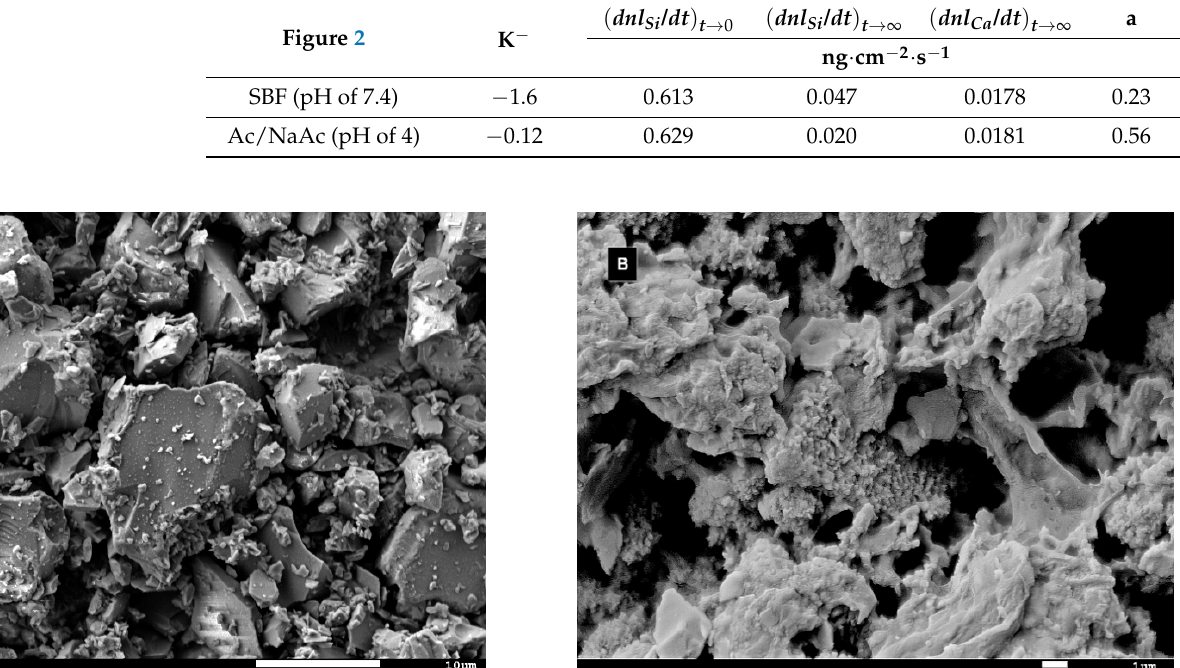
Figure 10. SEM micrographs ( A ) of the VB glass powder after the 4-day flow-through test ( B ) and the inline ICP test in Ac/NaAc fluid with a pH of 4. 4. Discussion There is no uniform method for selecting media that simulate human plasma condi- tions to suitably study the kinetics of potentially bioactive materials, especially when the controlled release of ions with additional functionalities is considered. Unlike Kokubo’s SBF, which is used to study the precipitation of carbonate phosphate phases that form a firm interface with a potentially bioactive material, there are no standardized guidelines on which solution to use for kinetic studies in simulated human conditions. A solution without dissolved inorganic ions that is buffered to a pH of 7.4 with Tris is usually selected to stimulate the dissolution of bioactive materials under the conditions of the highest sol- ubility and the lowest saturation with respect to calcium phosphate precipitation [10,11,25,40]. Acetic acid buffered with sodium acetate is used when an inflammatory en- vironment is tested in vitro [15,17,40]. Other solutions with or without calcium or phos- phates at various concentrations are also used [32,33]. Fluids containing proteins are of major interest for bioresponse investigations [11,18,25,41]. Data from static tests in SBF are often used to evaluate the kinetics of ion release, and the interpretations are frequently based on time–concentration trends starting from the first day of the experiment. At this point, there is already a high probability that a steady state has been achieved and the rate of dissolution of bioactive glass will gradually decelerate to zero, especially in solutions with a high ionic strength.